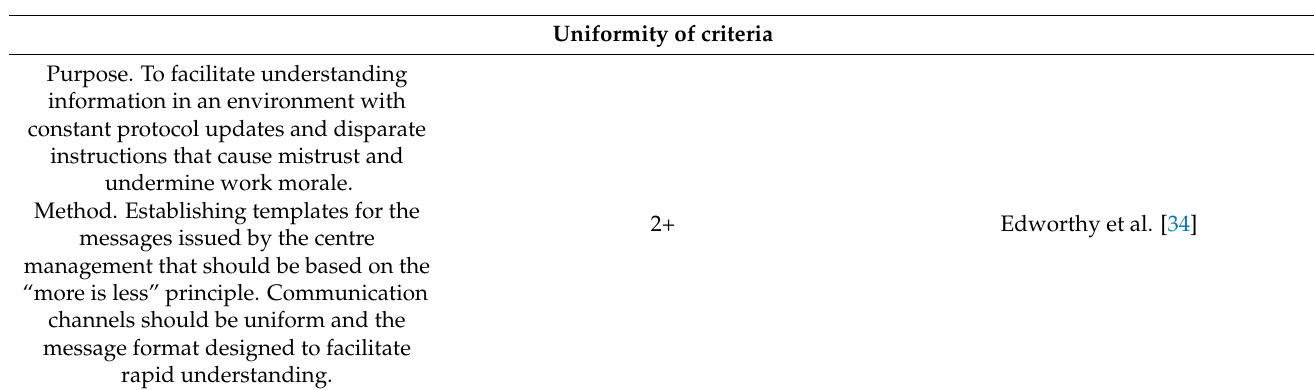
Table 2. Cont. Uniformity of criteria